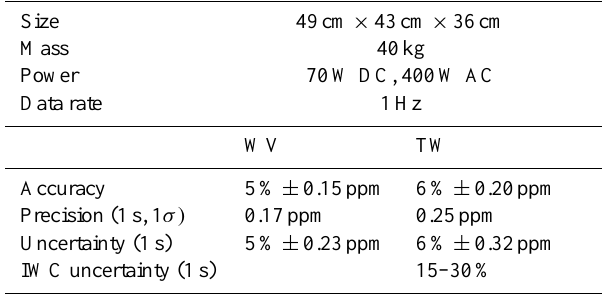
Figure 1. Schematic of the NOAA Water instrument showing the inlet pylon, optics sub-enclosure, and some of the principal in- strument components: (a) absorption cells within the optics sub- enclosure, (b) optical sub-enclosure heaters, (c) CompactRIO data system, (d) gas bottles, (e) sample mass flow control valves, and (f) cell pressure control valves. The enclosure structure and pylon are fabricated from aircraft-grade aluminum.